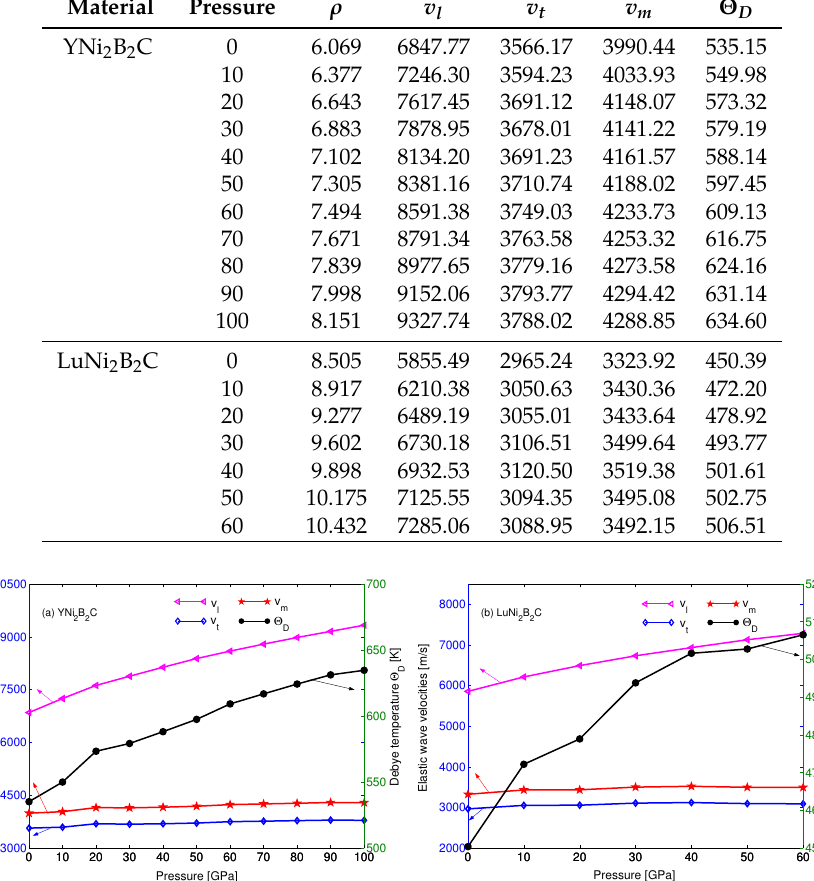
Figure 7. The pressure dependence of the longitudinal ( v l ), shear ( v t ) and average ( v m ) elastic wave velocities and Debye temperature Θ D for ( a ) YNi 2 B 2 C and ( b ) LuNi 2 B 2 C,